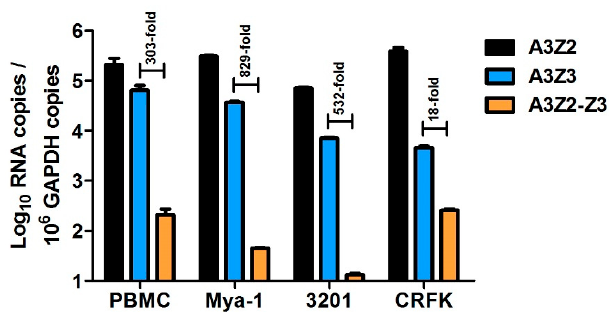
Figure 2. A3 gene expression patterns vary in primary cat peripheral blood mononuclear cells (PBMCs) and cell lines. Within each cell type, differences between A3Z2, A3Z3, and A3Z2-Z3 gene expression were all statistically significant ( p < 0.001). Experiments were conducted in quadruplicate and error bars represent standard errors of the means. We previously published these data for PBMC, Mya-1, and CRFK cells [64]. Data for 3201 cells is newly published here.